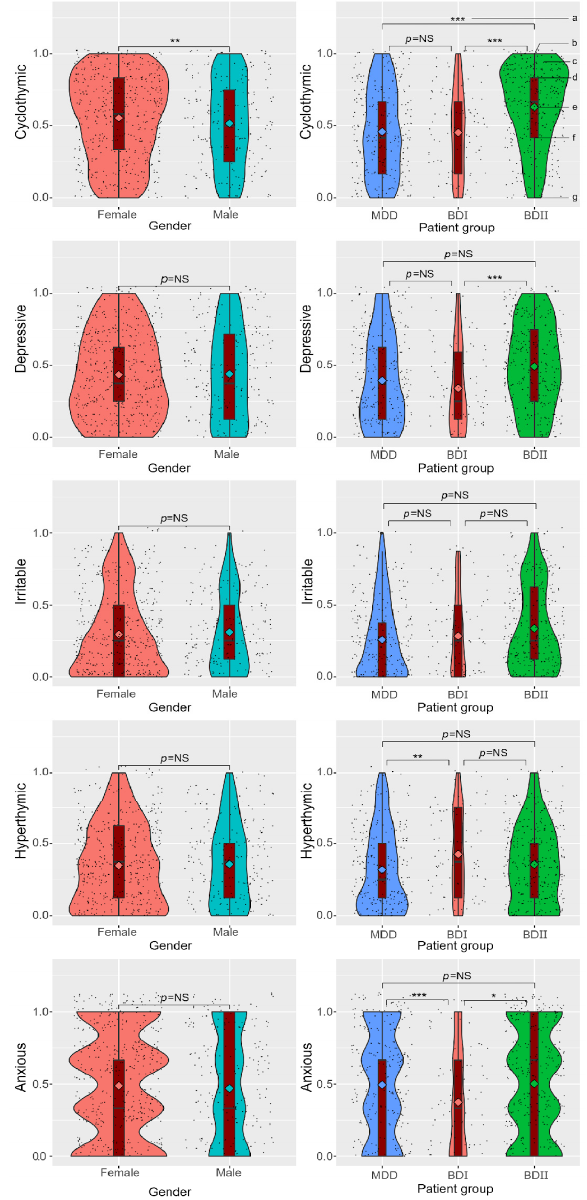
Figure 2. Violin plots depicting the distribution of five temperaments by gender or patient group. (a) p -value of median regression; * p < 0.05, ** p < 0.01, *** p < 0.001; NS = no significance. (b) Upper adjacent value. (c) Distribution of temperaments. (d) Third quartile (75%ile). (e) Median. (f) First quartile (25%ile). (g) Lower adjacent